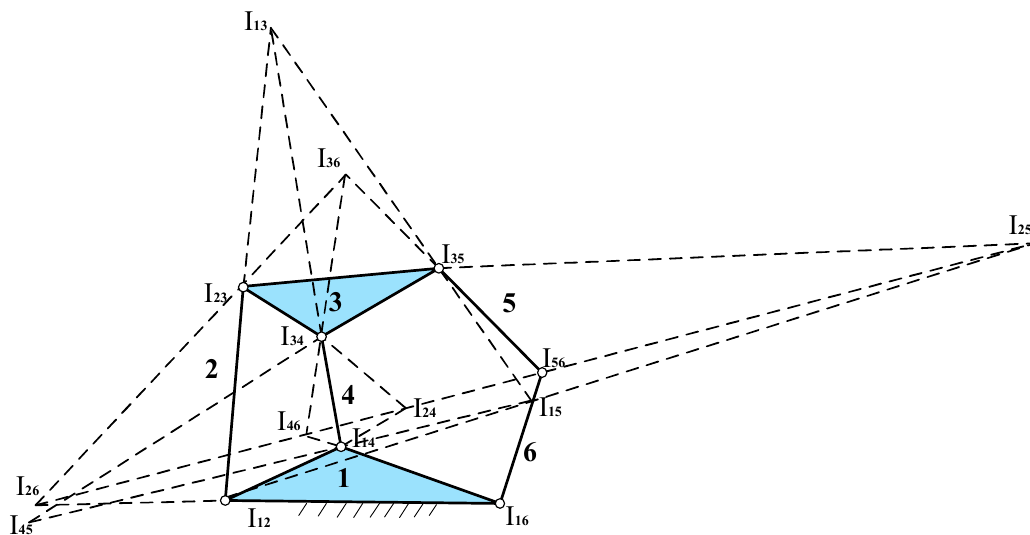
Figure 3. Instant centers of the Stephenson linkage.